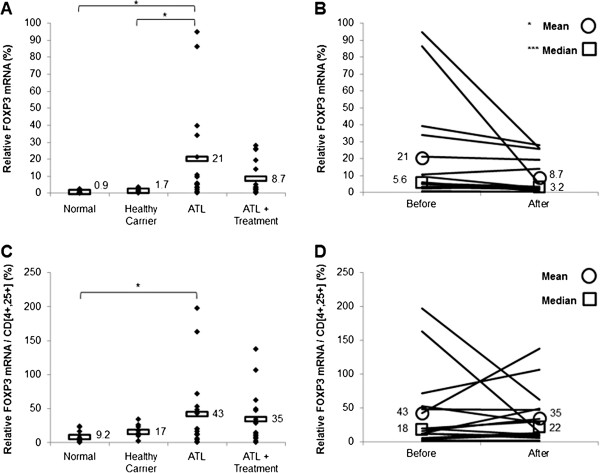
Treatment with arsenic/IFN/zidovudine decreased Foxp3 expression. A. Foxp3 transcript levels in normal blood donors (n=10), healthy carriers of HTLV-I (n=10) and ATL patients (n=16) at initiation and 30 days after treatment with arsenic/IFN/zidovudine. Rectangles represent mean values. B. Mean and median Foxp3 transcript levels of individual ATL patients at initiation and 30 days after treatment with arsenic/IFN/zidovudine. C, D. Relative expression of Foxp3 transcripts after normalization to the number of CD4+CD25+ ATL cells. All values are expressed as percentage of human beta2-microglobulin used as internal control. *, **, *** indicate p values less than 0.05, 0.01 and 0.001 respectively.